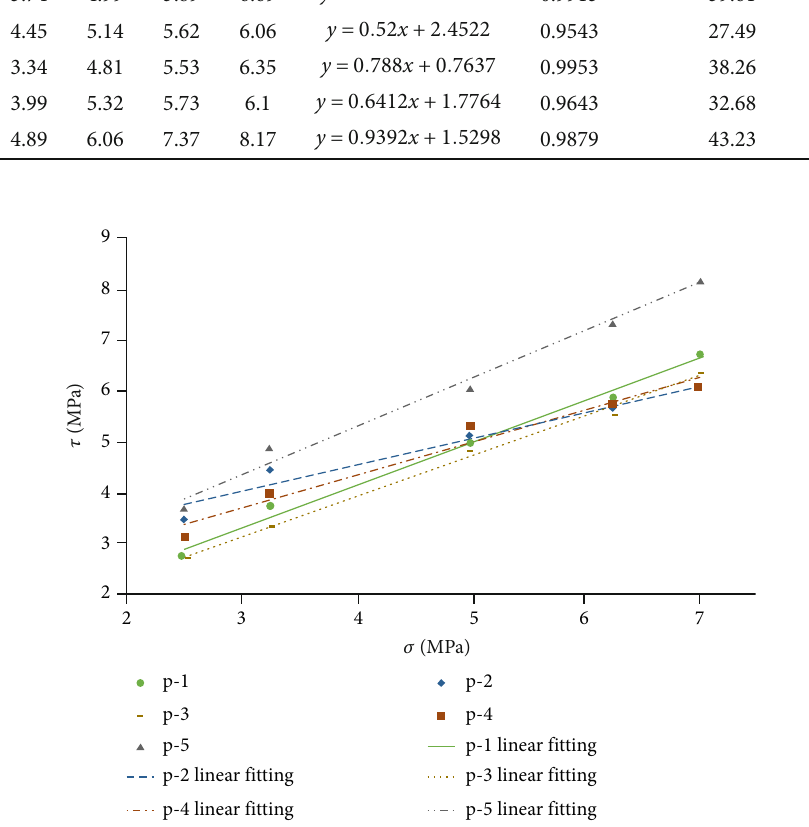
Figure 11: Relationship between di ff erent normal stresses and shear forces on